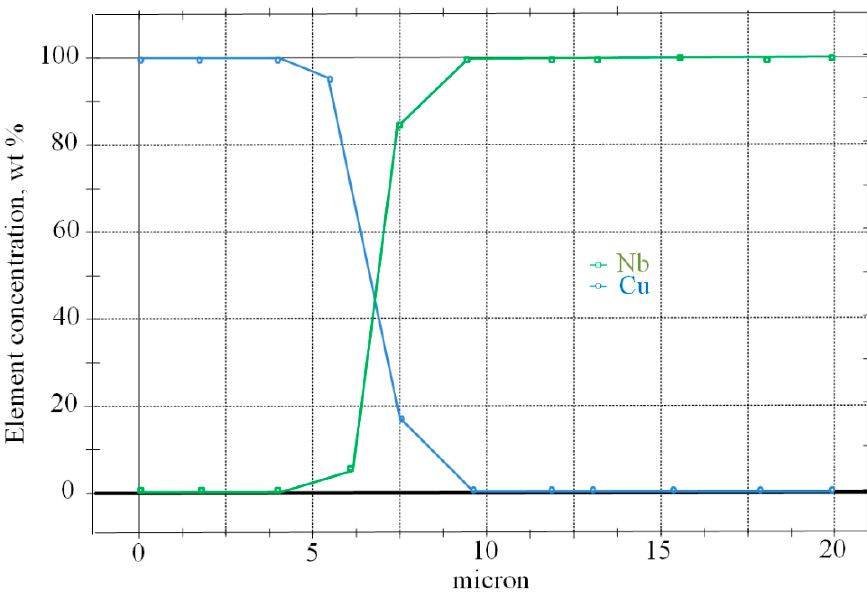
Figure 17. Diffusion welding scheme 12KH18N10T+Cu+Nb+VT-14.